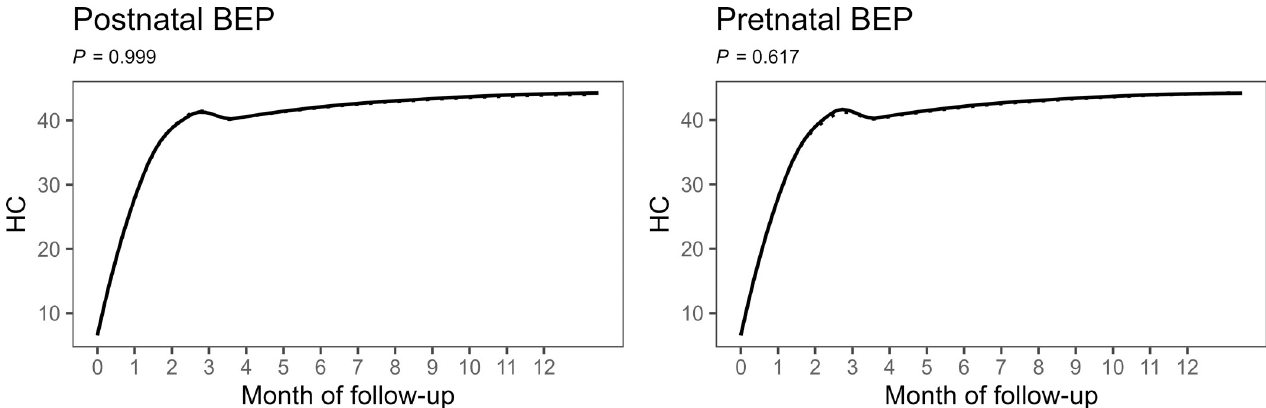
Fig 4. Monthly changes in head circumference by postnatal (left panel) and prenatal (right panel) intervention arms with the dashed lines representing the control group (IFA) and solid lines representing the intervention group (IFA + BEP). Line graphs represent locally weighted scatterplot smoothing of observed values. Group differences were estimated using mixed-effects models with random intercepts for infant and random slopes for intervention time, with fixed effects including time spline variables with 6 knots, intervention group, and time × group interaction terms adjusted for allocation to the other intervention, clustering indicators (health center and randomization block), and a priori determined prognostic factors (maternal height, BMI, MUAC, hemoglobin, age and gestational age at inclusion, and parity). Group difference was tested by likelihood ratio test comparing a model with and without time × group interaction terms. BEP, balanced energy–protein supplement; BMI, body mass index; IFA, iron–folic acid; MUAC, mid-upper arm